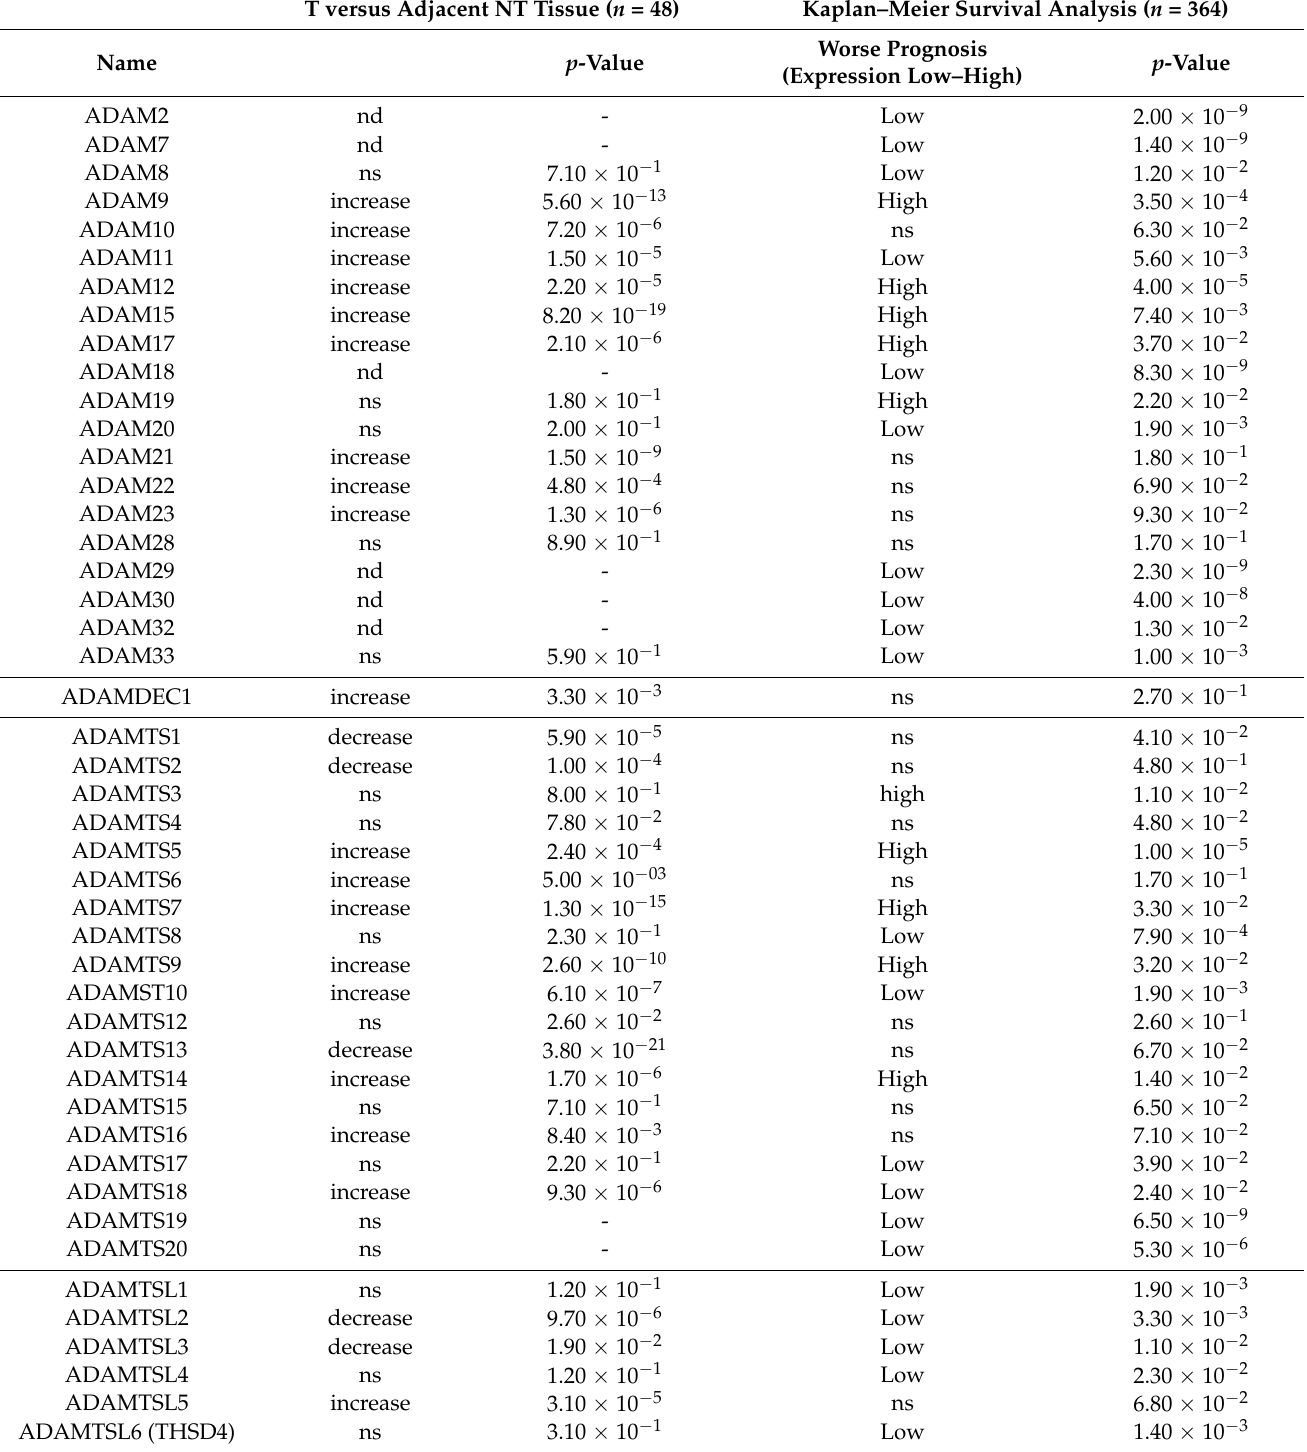
Table 1. Adamalysin expression in liver cancers from The Cancer Genome Atlas (TCGA) database. nd; not detectable; ns, not